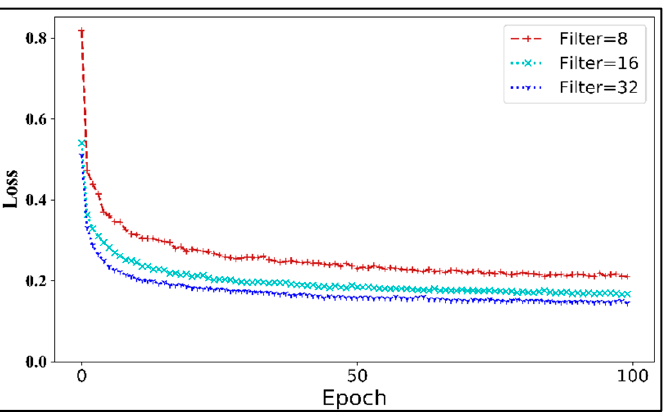
Figure 4. Convergence error of cost function with three different filter sizes.